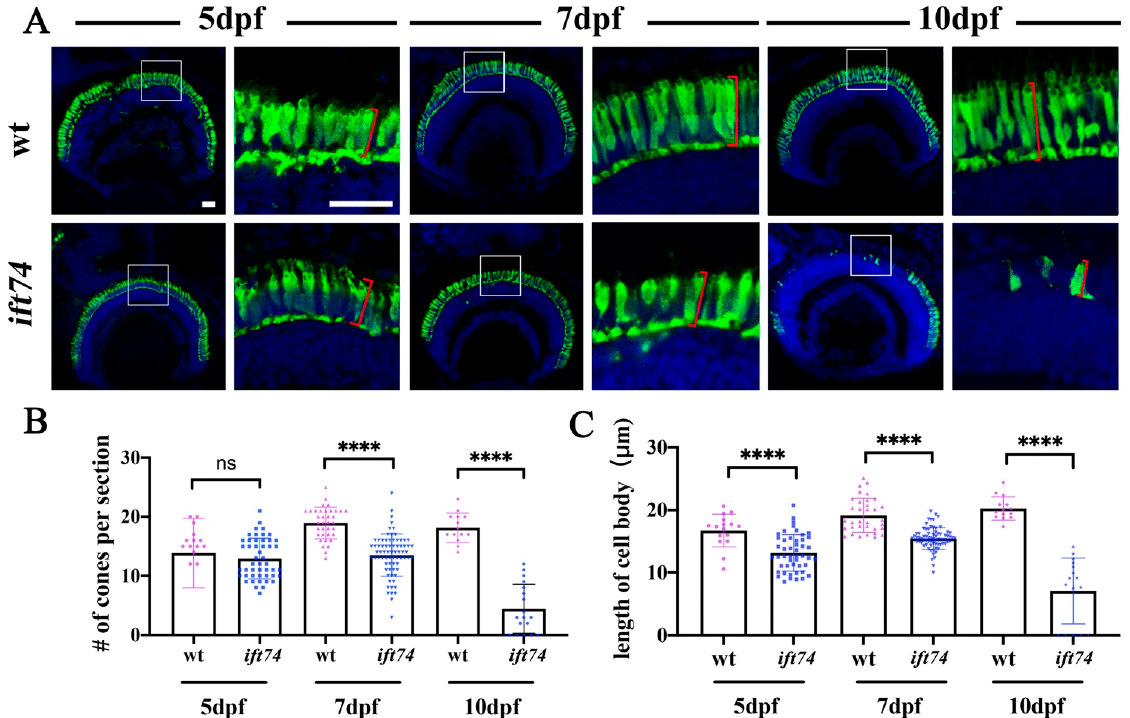
Figure 3. Slow photoreceptor degeneration in ift74 mutants. ( A ) Confocal images showing the cell bodies of red and green double cones in wild-type and ift74 mutant larvae at different stages as indicated. The double cones were stained with zpr-1 antibody (green), and nuclei were stained with DAPI (blue). Enlarged views of the boxed area are shown on the right. ( B , C ) Statistical results showing the number of cones per retina section and length of cone cell body in different groups as indicated. Measurements of the cell body length are shown in panel ( A ) (Red square brackets). Scale bars: 20 µ m. **** p < 0.0001, ns, no significant.